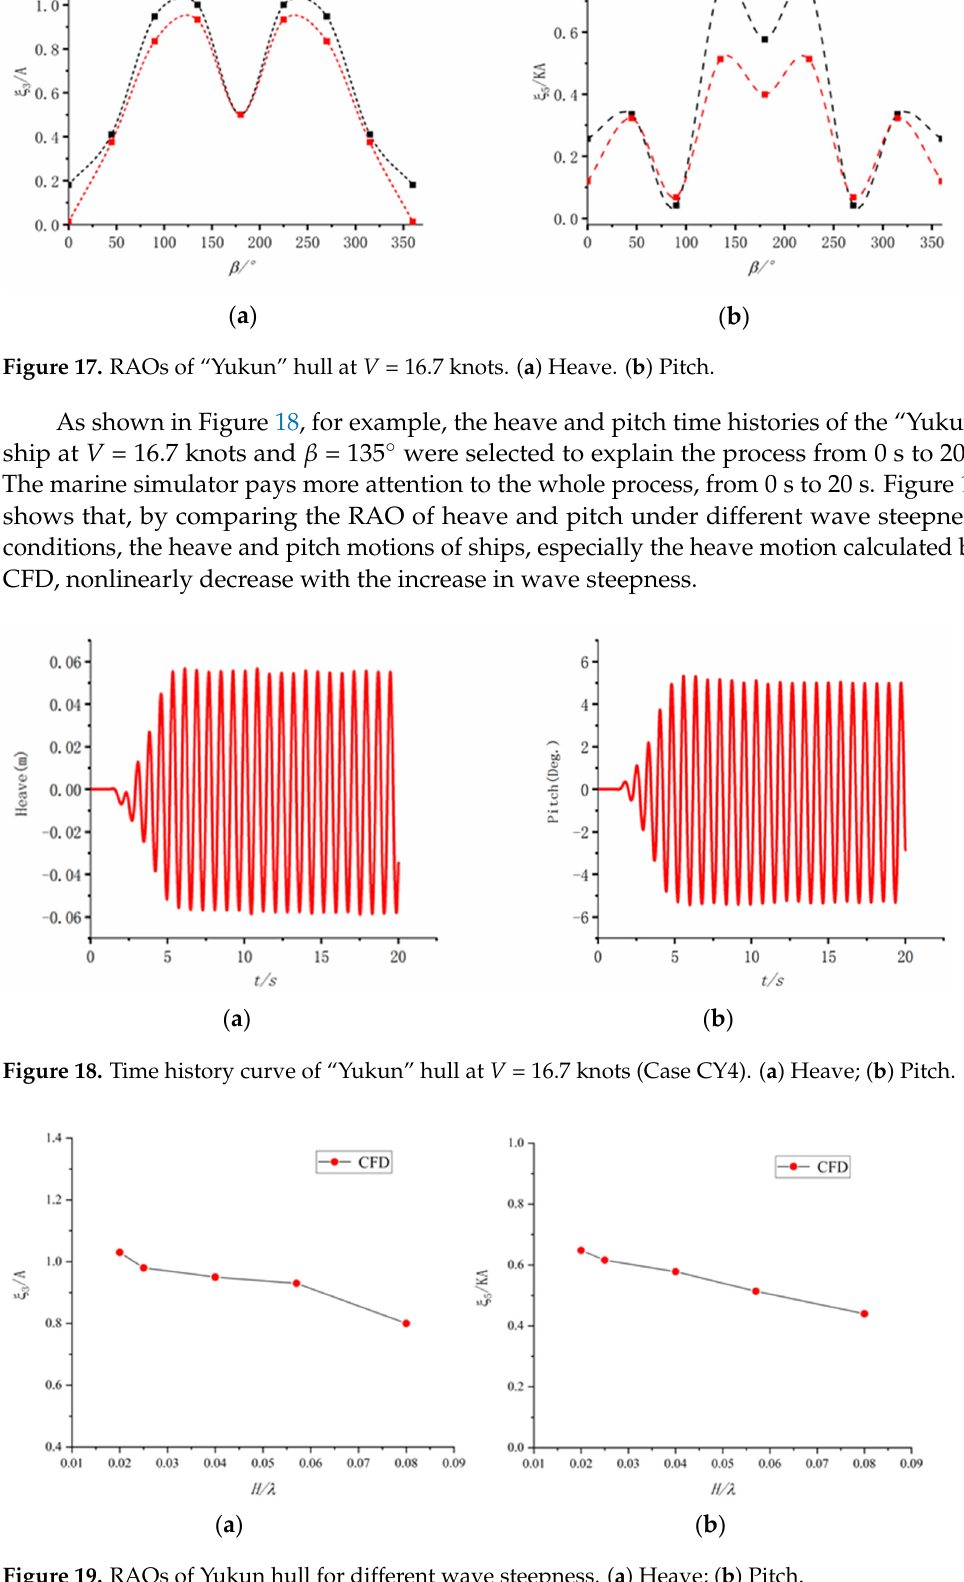
Figure 20. Waveforms in one cycle (Case CY9). In general, when the wave angle is about 135°, the sag amplitude and pitch amplitude of the ship reach their maximum, and the hull surface pressure coefficient and friction coefficient reach their maximum as well. Consequently, ship operators must try to avoid the angle of 135° angle or so between the “Yukun” and the wave.